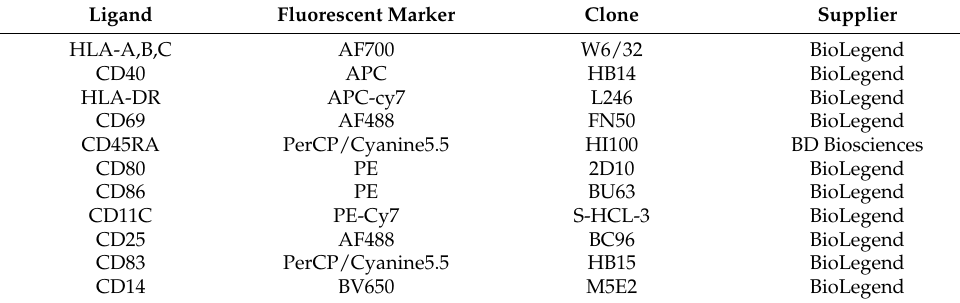
Table 1. Antibodies used in this